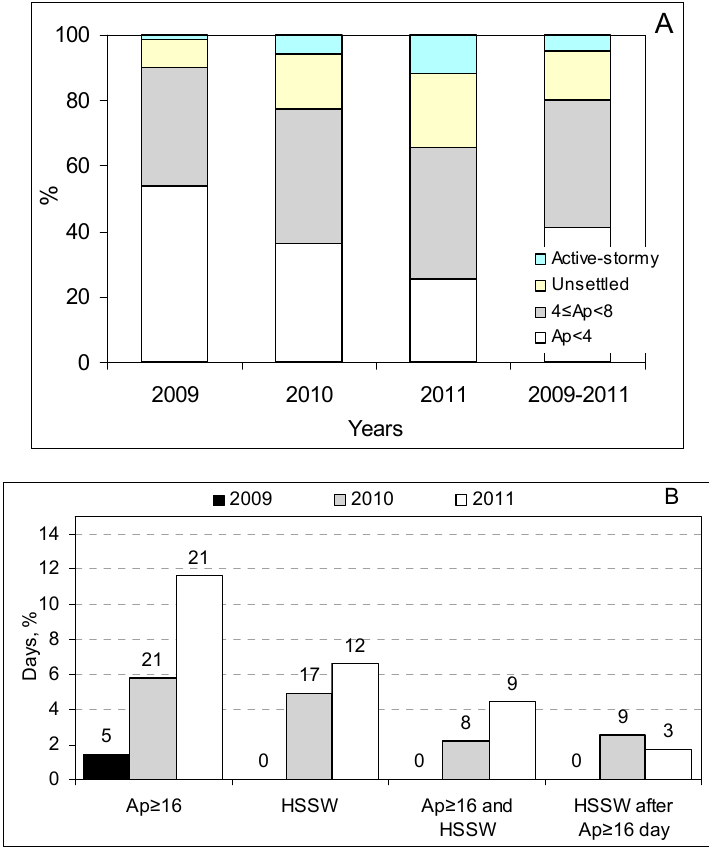
Figure 2. The distribution of the daily geomagnetic activity level ( A ) and the days of high-speed solar wind (HSSW) ( B ) during the studied period.